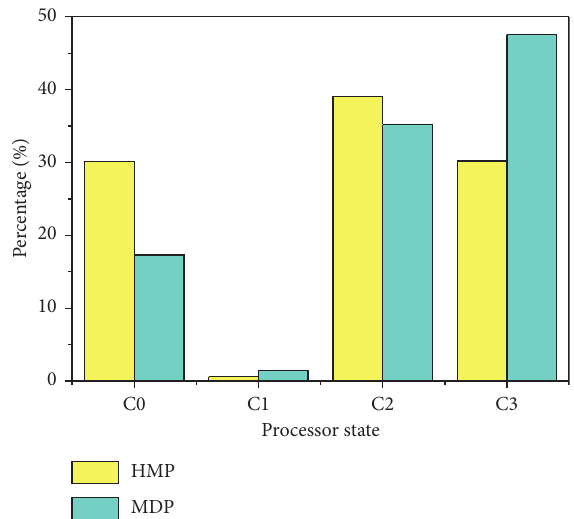
Figure 5: Probability of mutual transition of user’s mobile network